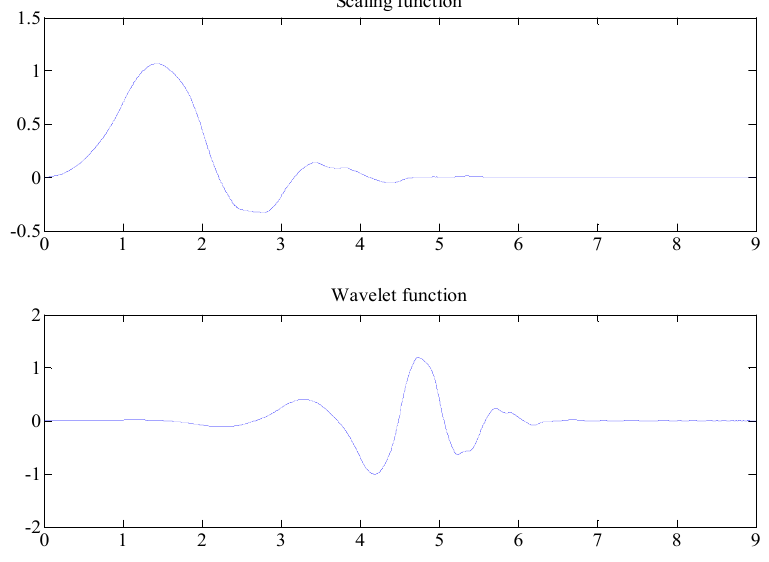
Figure 12. Graph of the db5 wavelet scaling function and wavelet function.